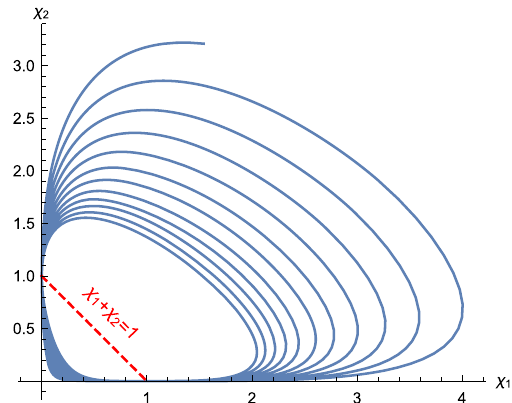
Fig. 9 Numerical simulation for χ 1 ( N = 0 ) = 100 and χ 2 ( N = 0 ) = 100 initial conditions with ξ = 100, M p =1 and λ = 1. The above initial conditions guarantee the smallness of de Sitter expansion and provide the simulation to have more resolution on the oscillations. One has to note that all the spiral trajectory is one curve in the 3 . 3585 < N < 3 . 4500 interval. All the oscillations contain the potential central point